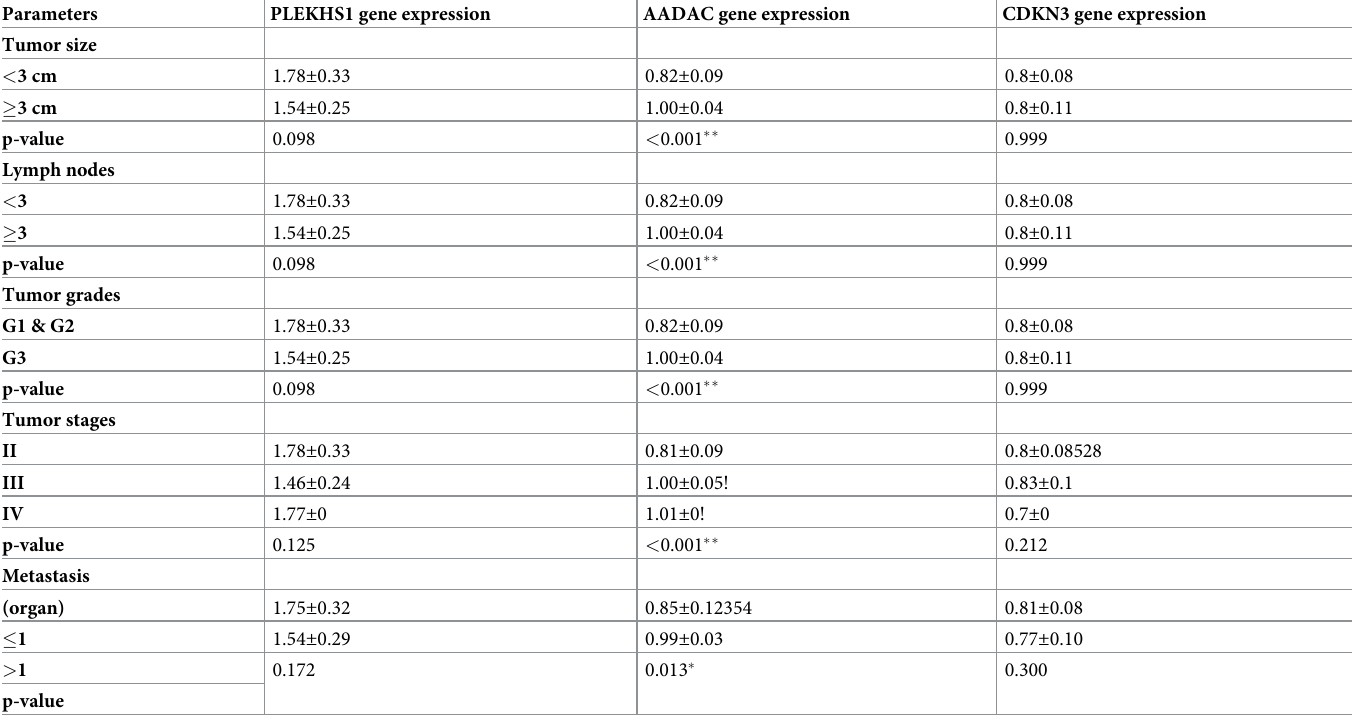
Table 3. Comparison between the levels of the studied parameters in different disease characteristics among the gastric carcinoma group.